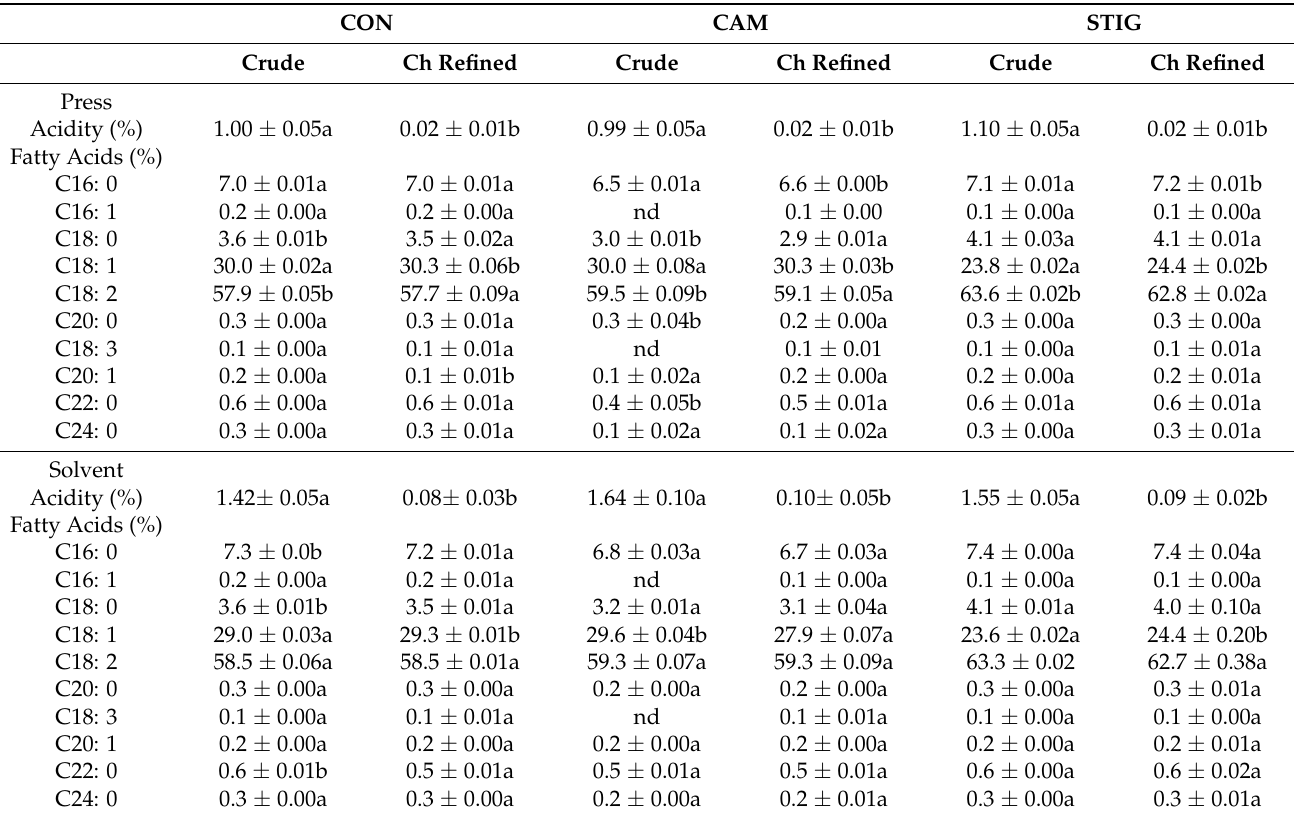
nd, not detected. Results are expressed as mean values ± standard deviation ( n = 4 for bleached oils and n = 3 for ChR oils). Different letters indicate significant differences between bleached and ChR oils for each sample ( p < 0.05), according to the Student’s t